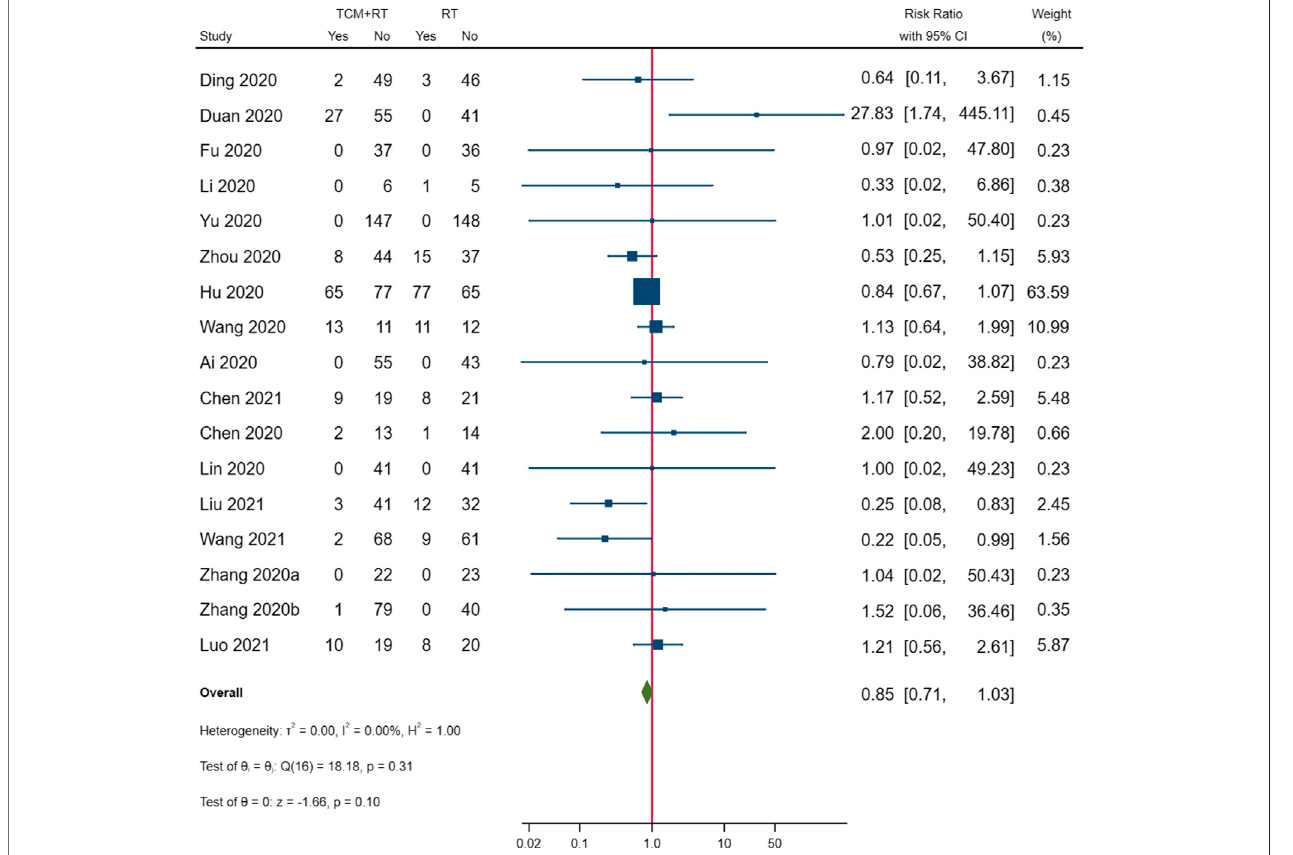
FIGURE 10 | Forest plot of incidence of adverse